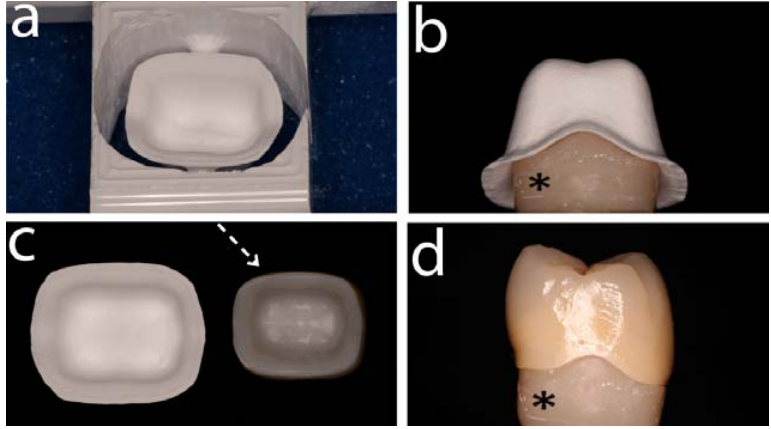
compensation for the controlled sintering process. Note the shadow of the porcelain through the sintered core segmented (white arrow). (d) shows a mesial-side view of